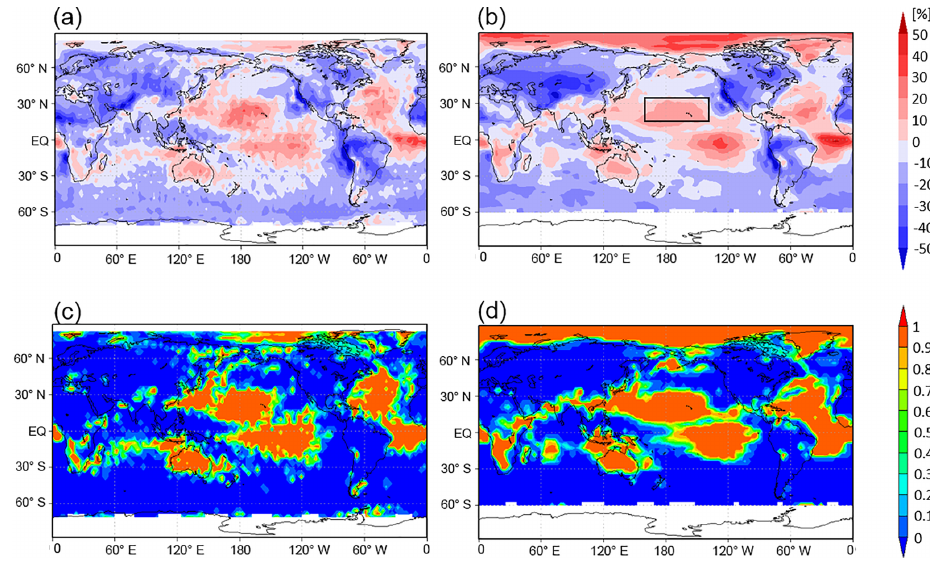
Figure 4. Cloud amount bias in the July mean with respect to the (a) CALIPSO and (b) ISCCP observations. The biases are for the ensemble mean of the MIROC5 PPE. Fraction of the PPE ensemble members, which have positive signs of the cloud amount bias, with respect to (c) CALIPSO and (d) ISCCP